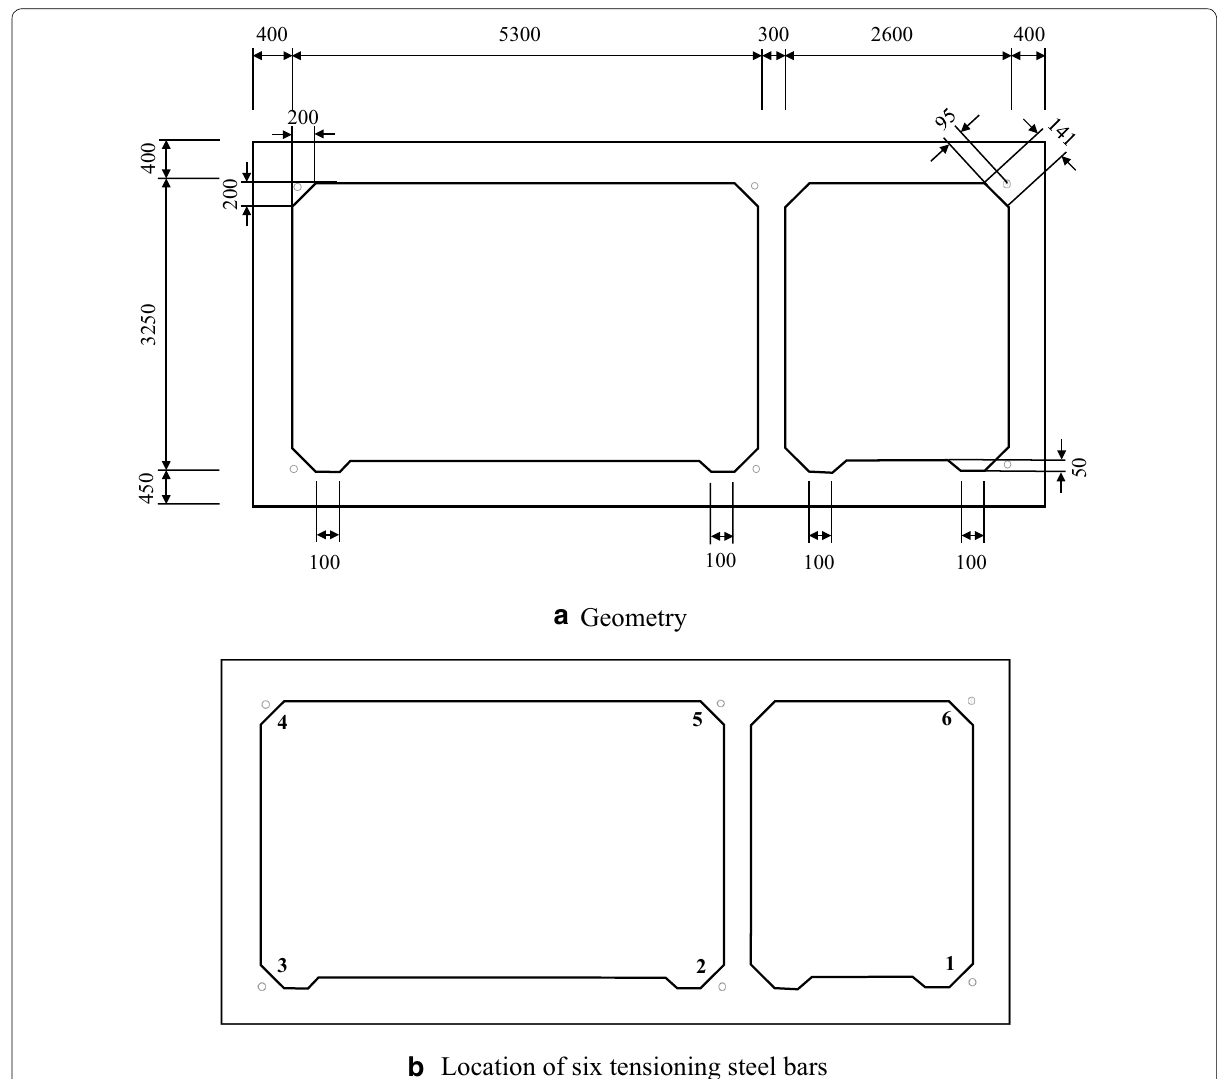
Fig. 5 Schematic diagram of full‑scale waterproofing test: a geometry; b location of post‑tensioning steel bars (units are in